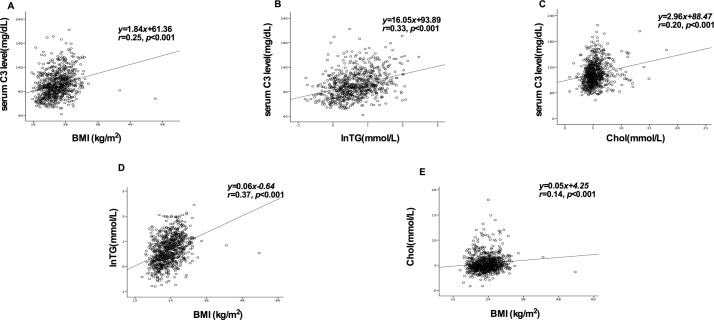
Correlation analysis assessed the relationship between any two indicators of BMI, serum C3, triglycerides and cholesterol.(A) Correlation between serum C3 levels and BMI at baseline; (B) Correlation between the normal conversion of triglycerides and serum C3 levels; (C) Correlation between cholesterol and serum C3 levels; (D) Correlation between BMI and normal conversion of triglycerides; (E) Correlation between BMI and cholesterol.